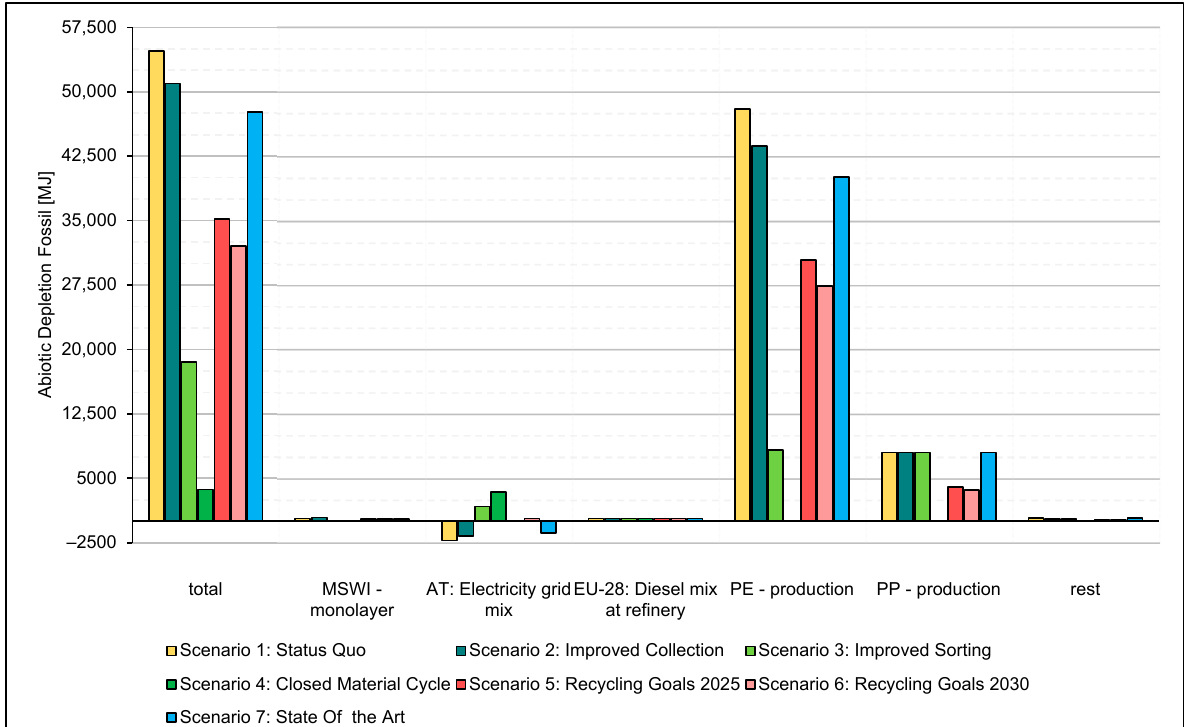
Figure 13. GWP of the individual processes over the product lifecycle. Mixed Solid Waste Incineration.